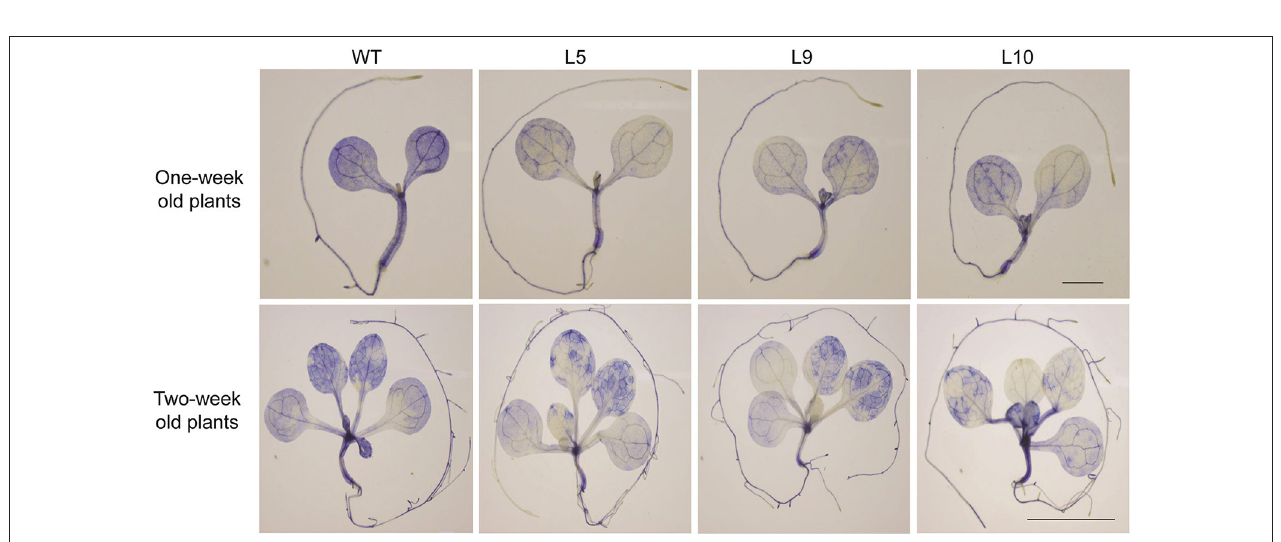
FIGURE 7 | NBT staining of 1 week (scale bar 1mm) and 2 weeks (scale bar 1cm) old seedlings. Plants were given heat stress and were then stained with NBT to visualize the superoxide anion accumulation after the stress treatment.